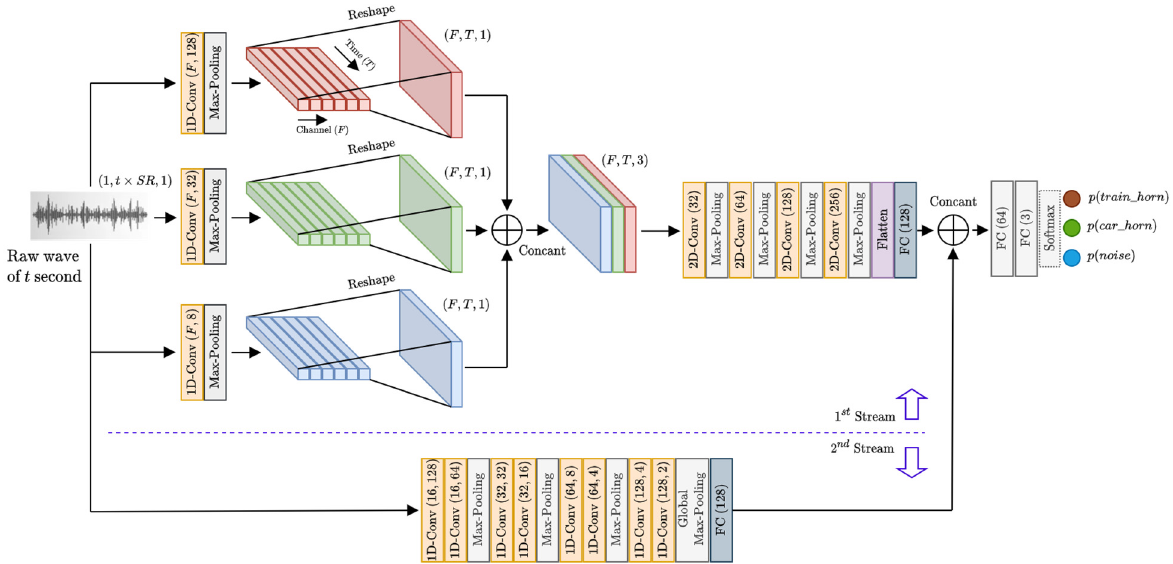
Figure 2. The general structure of the THD-RawNet in the TH-TAD system. (cid:1845)(cid:1844) is the sampling rate, (cid:1872) is the input length (in seconds), (cid:1832) is the number of filters in a 1D-Conv layer, “Concat” stands for concatenation operation, and FC denotes a fully connected layer.